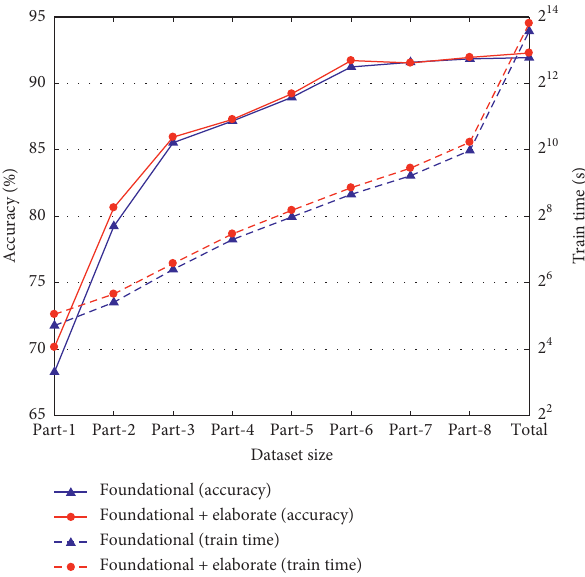
Figure 5: The impact of the alphabet size in